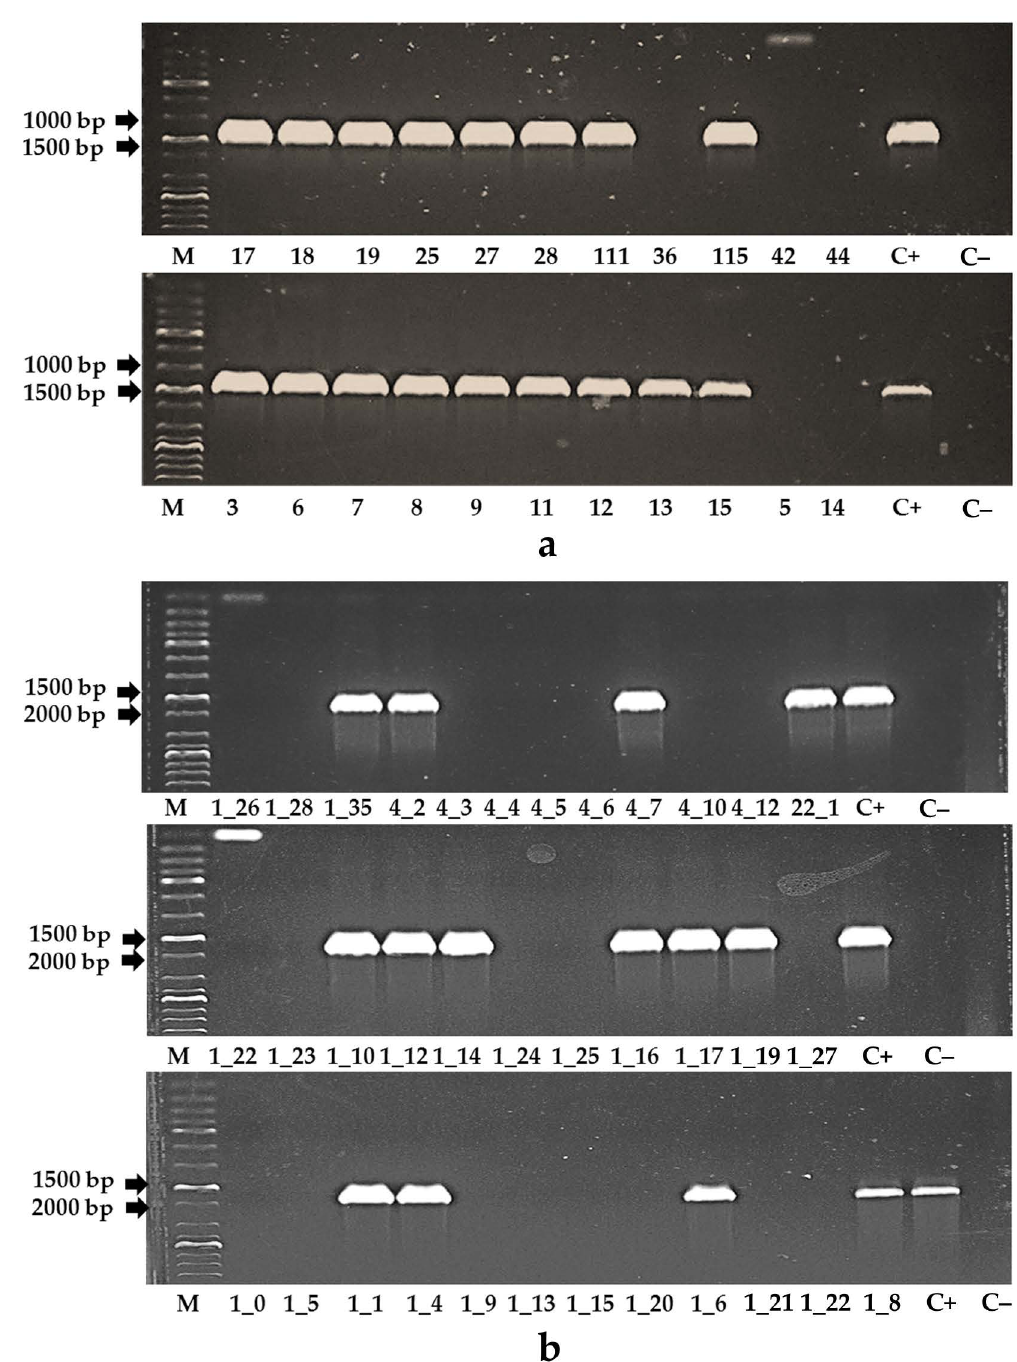
Figure 2. PCR analysis of DNA from tomato regenerants obtained using the plasmid vectors p35S-antM2-sM2 ( a ) and pSmAMP2-antM2-sM2 ( b ). The numbers below the gel images indicate the numbers of the individual transformants. “M” is a GeneRuler 1 kb Plus DNA Ladder (Thermo Fisher Scientific, Waltham, MA, USA). “C+” is a positive control: pSmAMP2-antM2-sM2 ( a ) or p35S-antM2-sM2 ( b ) constructs, respectively, were added as a